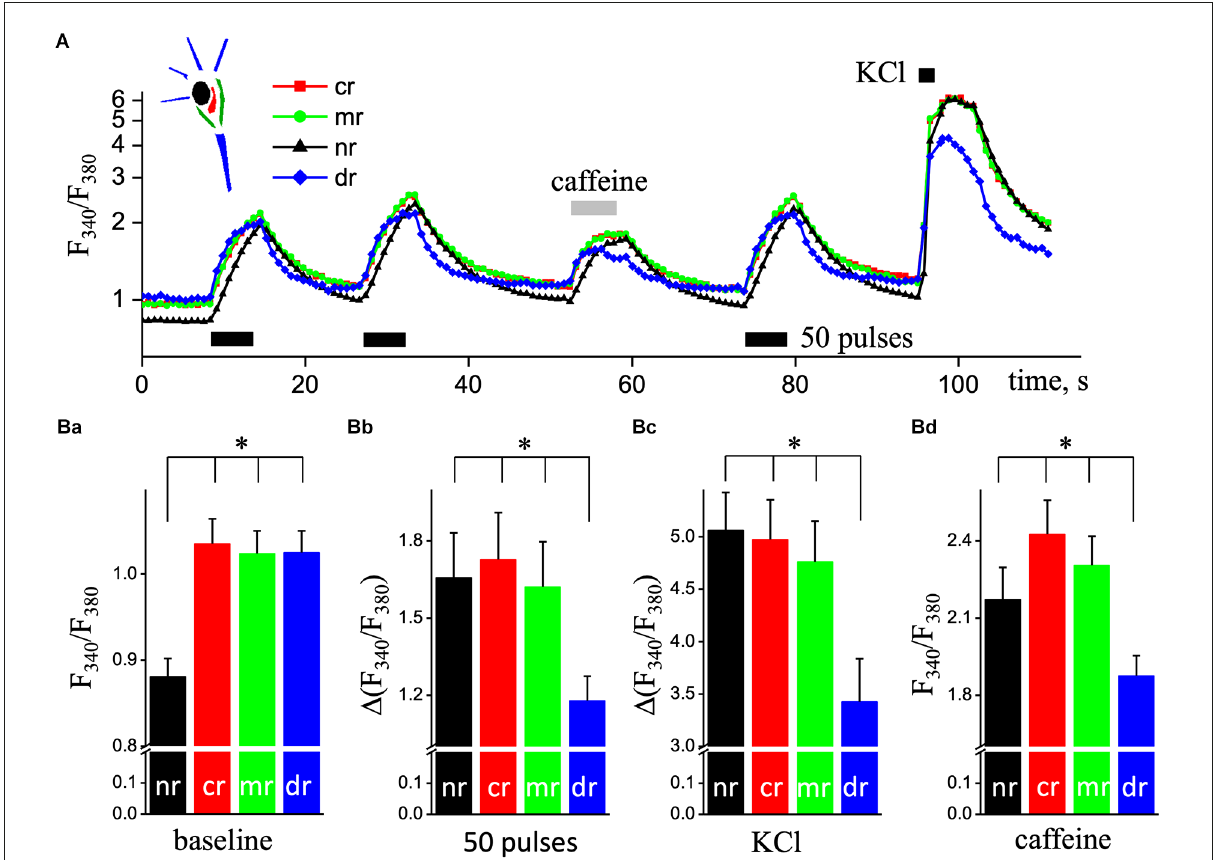
FIGURE1 Ca 2 + responses in different ROIs of pyramidal hippocampal neurons triggered by electrical field stimulation and application of depolarizing and caffeine solutions. (A) Transient increases in [Ca 2 + ] i are triggered by two series of 50 pulses of EFS (black rectangular, 9 Hz) followed by the application of caffeine (caffeine, light gray rectangular; 10 mM and 5 s) and a series of 50 pulses of EFS and depolarizing solution with 50 mM KCL (KCl, black square, 5 s). Ca 2 + responses were recorded in the central space (cr; red squares line), sub-membrane (mr; green circles line), dendritic tree (dr; blue diamond’s line), and nucleus (nr; black triangles lines) regions of cultured hippocampal neurons loaded with the fluorescent Ca 2 + indicator Fura-2. Ratios (F 340 /F 380 ) are presented in natural logarithmic scale. The top left corner represents a schema of neurons’ area selection. The bottom panel (B) shows quantified responses for four studied regions in pyramidal neurons. (Ba) Mean value of basal Ca 2 + levels before any stimulus; part (Bb) is the mean values of the amplitudes of second Ca 2 + transients caused by EFS; part (Bc) is the mean values of the amplitudes of Ca 2 + transients evoked by depolarizing solution; part (Bd) is the mean values of Ca 2 + peaks evoked by 5 s application of 10 mM caffeine, as an agonist of RyRs. The black bars are data for the nucleus (nr); the red bars are data in the central space (cr); the green bars are sub-membrane regions (mr), and the blue bars are dendritic trees of neurons (dr). Results are mean ± S.E. of 30 individual cells from 10 different experiments. ∗ P <